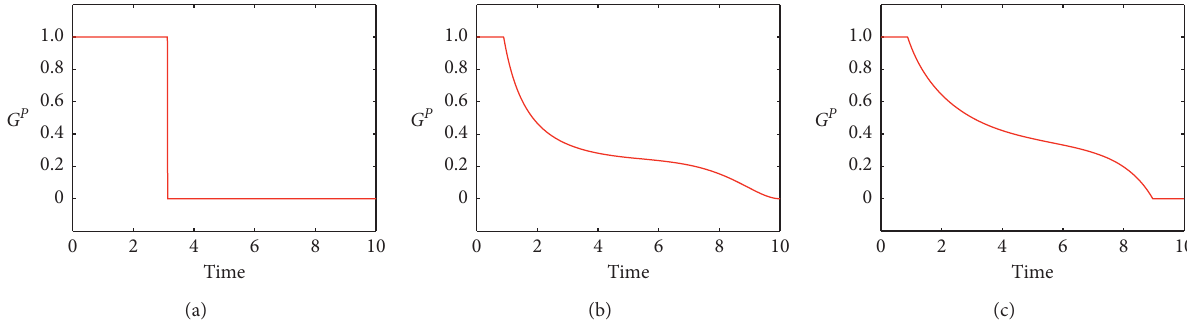
( x ) � θ 1 ( x ) and θ ( x ) � θ 1 ( x ) , (b) 1 2 1 2